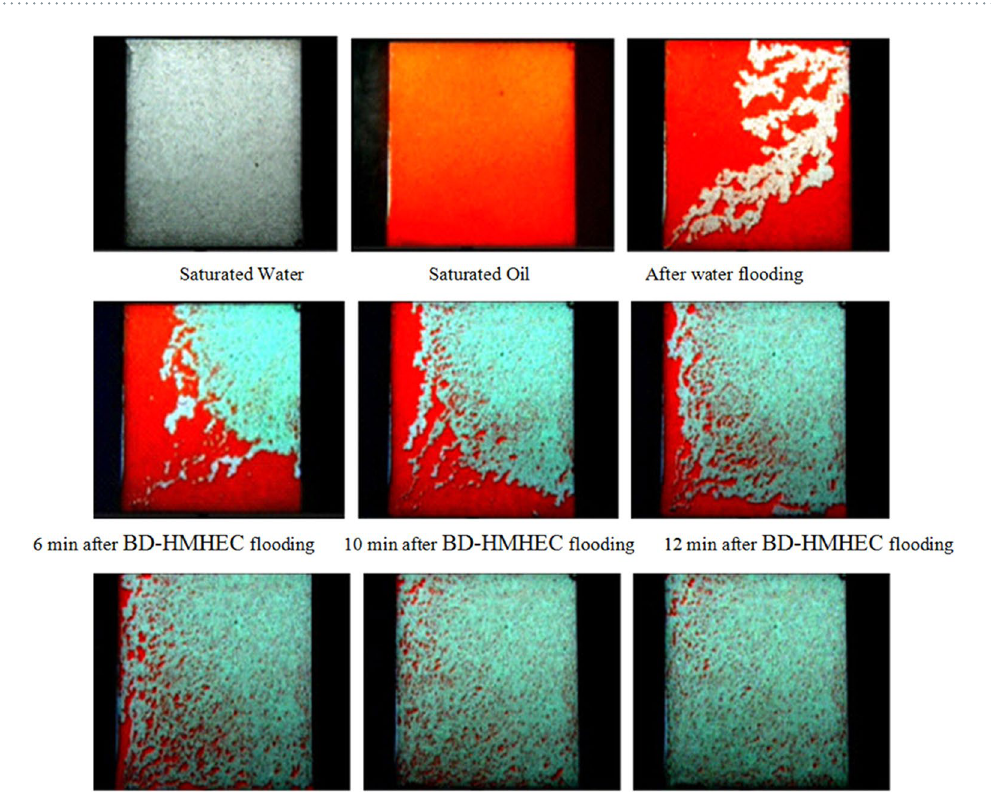
Figure 11. Visual evaluation of BD-HMHEC solution oil